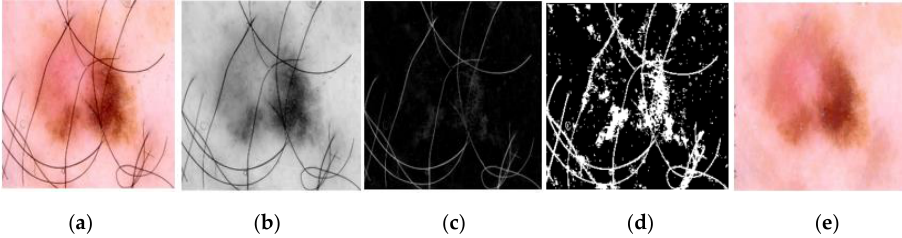
Figure 2. Sample of hair removal. ( a ) Original image (256 × 256). ( b ) Corresponding grayscale image. ( c ) Black hat image. ( d ) Thresholding image. ( e ) Inpainting.